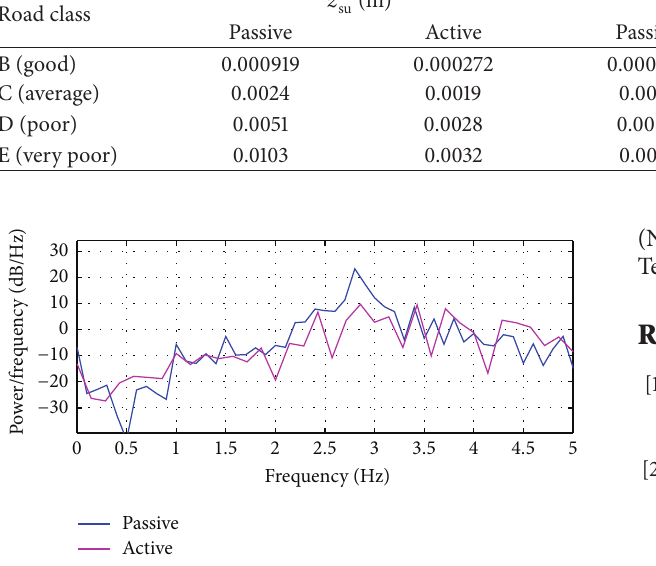
Figure 11: The PSD of sprung mass acceleration.